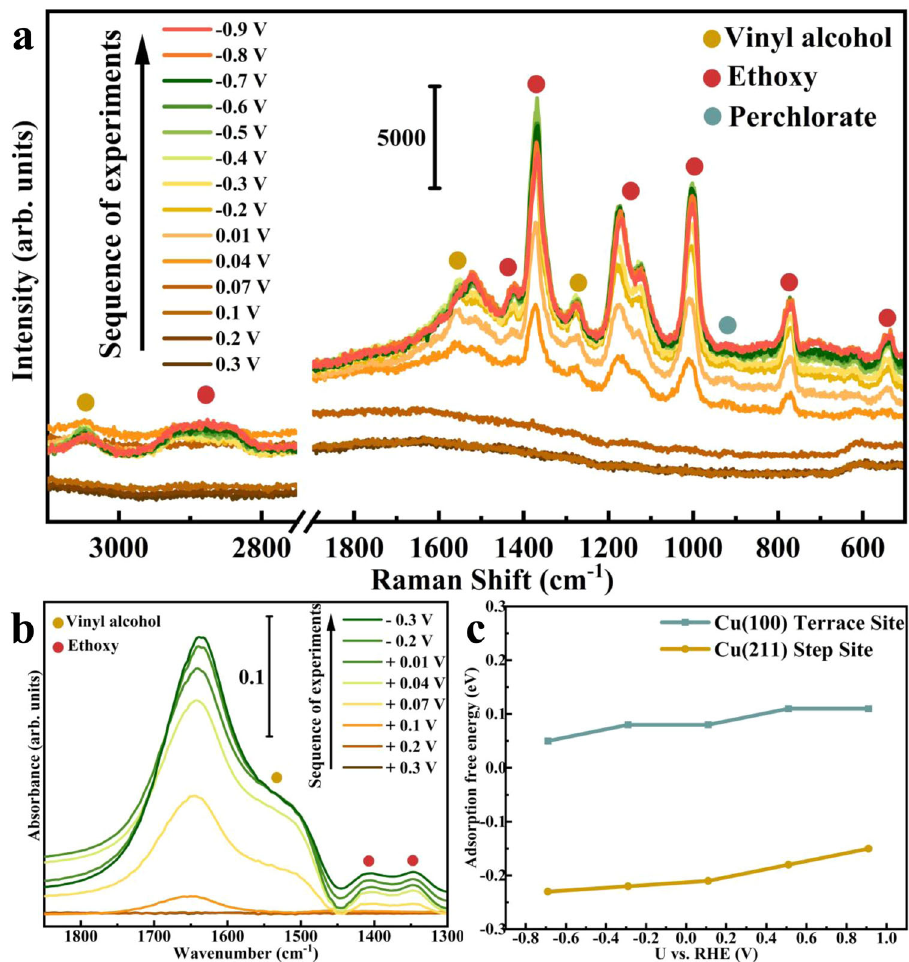
Fig. 3 | In situ Raman and ATR-SEIRAS spectra and GC-DFT calculated results. a In-situ Ramanand b ATR-SEIRASspectra(background spectrum was recorded at 0.4V) obtained on polycrystalline copper powder electrode as a function of